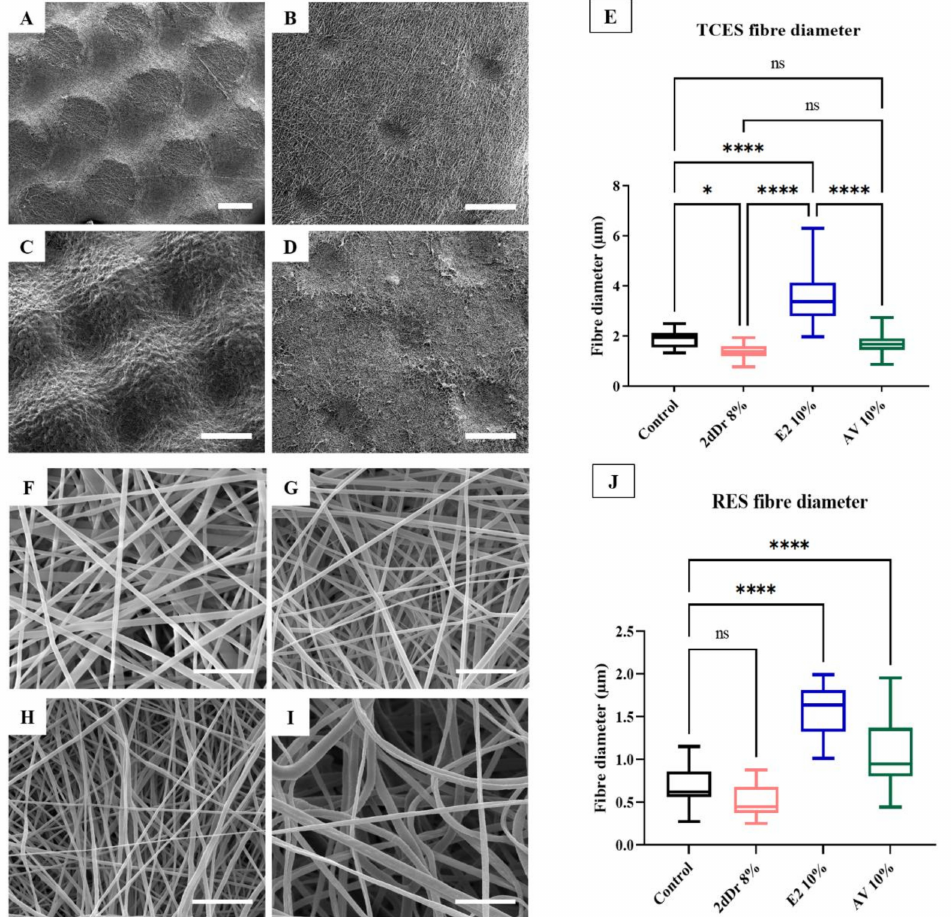
Figure 3. SEM micrographs of PCL TCES fabricated using the same patterned collector. ( A ) Control, ( B ) 8% 2dDr, ( C ) 10% E2, and ( D ) 10% AV. ( E ) Box plot of the TCES fiber diameter. SEM micrographs of PCL RES. ( F ) Control, ( G ) 8% 2dDr, ( H ) 10% E2, and ( I ) 10% AV. ( J ) Box plot of the RES fiber diameter. ns = no significance, * p < 0.05, **** p < 0.0001. N = 3, n =